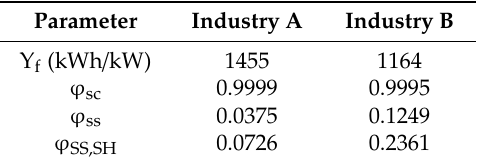
Table 2. Final PV system yield, annual self-consumption index, annual self-su ffi ciency index and annual self-su ffi ciency index during sunshine